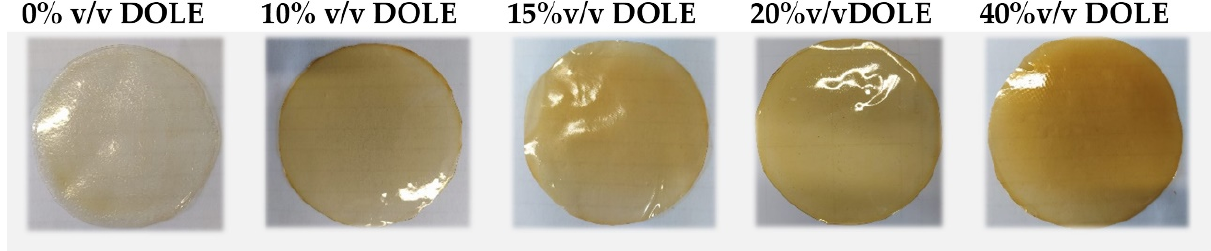
Figure 2. Chitosan-based films containing different volumes of DOLE (0–40% ( v / v )).